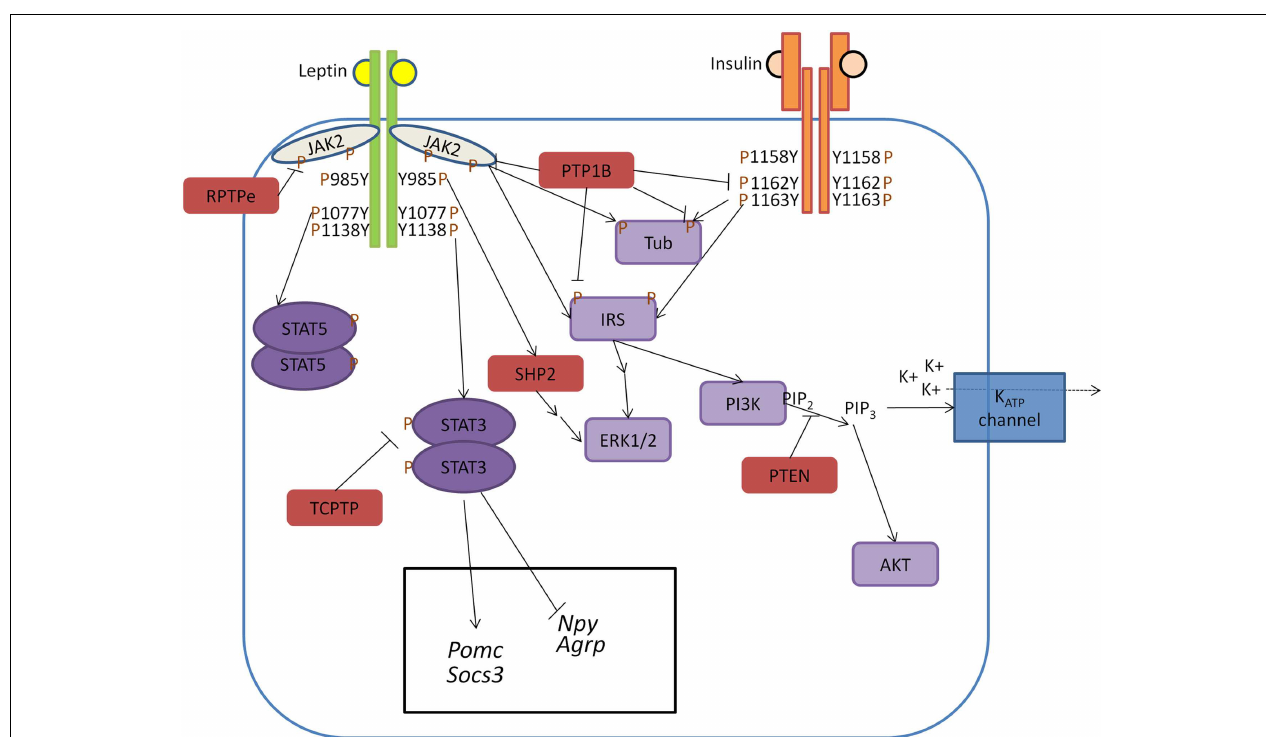
and mediate downstream PI3K and ERK1/2 signaling. In contrast to SHP2 which positively regulates leptin signaling, several PTPs can